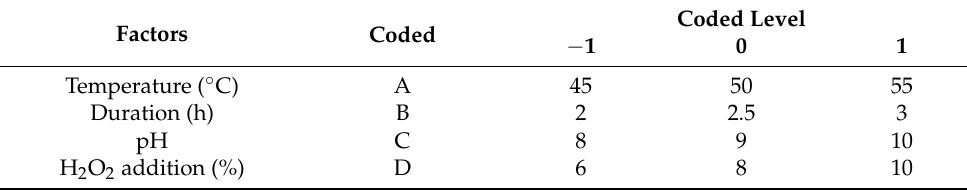
Table 2. Levels and codes of H 2 O 2 decolorization variables used in the Box-Behnken design. Factors